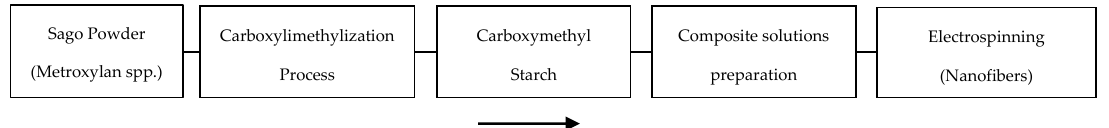
Figure 2. Processing route from a sago powder to electrospinning process to obtain the composite nanofibers.